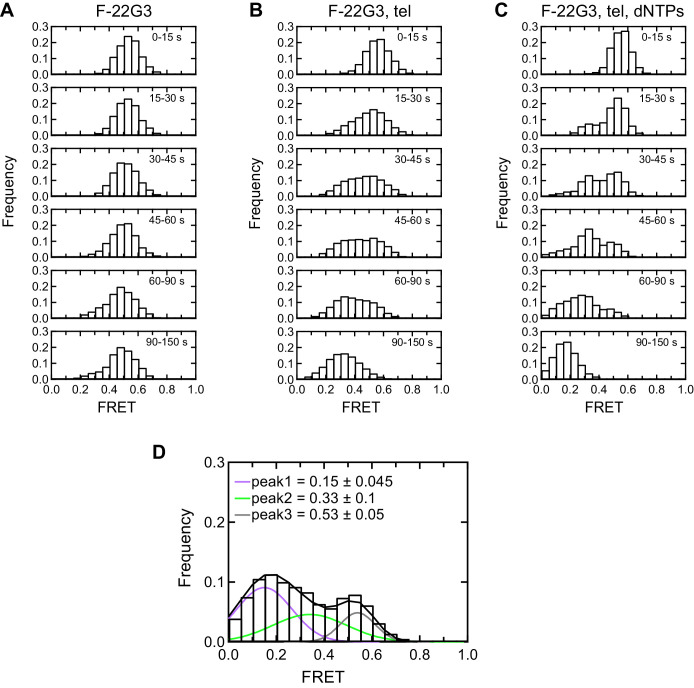
Histogram representations of F-22G3 FRET data.(A–C) Histograms showing changes in FRET values of a population of F-22G3 molecules under different experimental conditions over 150 s, binned into 15–60 s time intervals. (D) Histogram showing three different FRET populations in the presence of telomerase and dNTPs; a multiple Gaussian fit was applied to obtain the mean FRET peaks of these populations, with errors representing the curve fitting errorstandard deviation of the data. n = 99 (A), 125 (B) and 90 (C), (D) molecules, collected in 2–4 independent experiments.